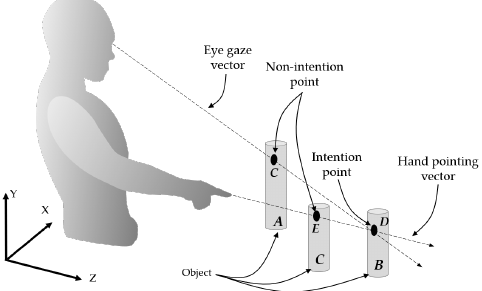
Figure 21. Intended point detection when eye gaze is obstructed by an